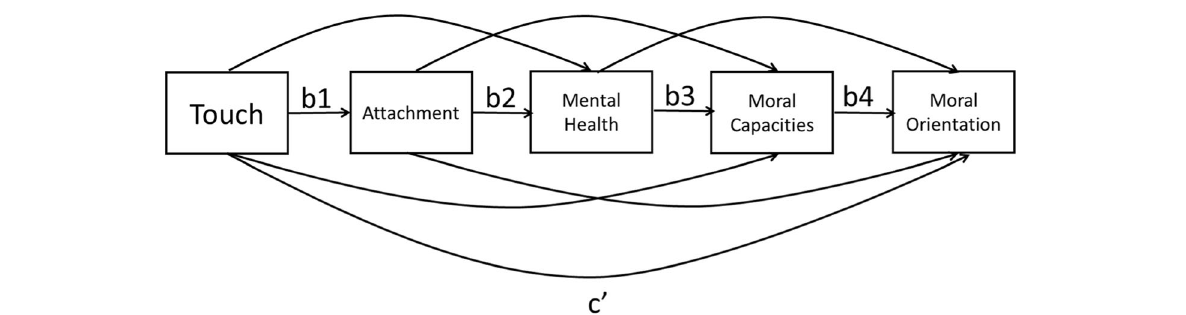
Fig. 3 Theoretical model for mediation across constructs: from touch (positive touch and lack of corporal punishment in childhood) to attachment (security), mental health (anxiety and depression), and moral capacities (empathy, perspective-taking, or personal distress) and then to moral orientation (social engagement, or self-protectionism as social withdrawal or social opposition)